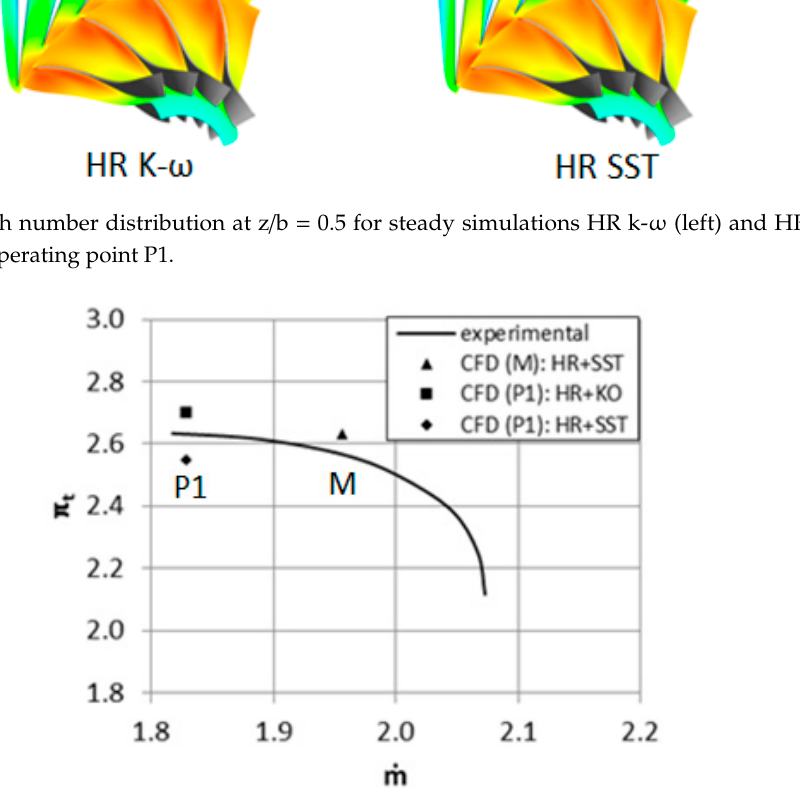
Figure 5. Total pressure ratio at plane 8M.